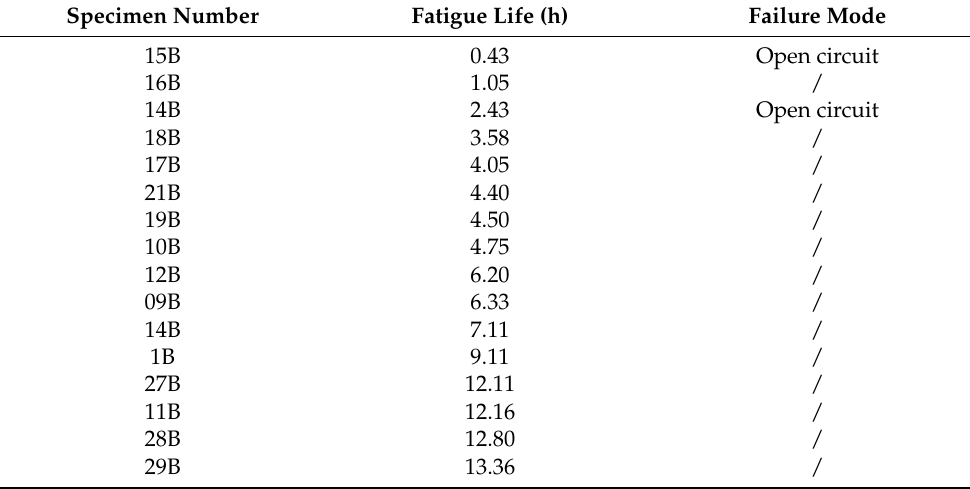
Table 10. Test results for random vibration.